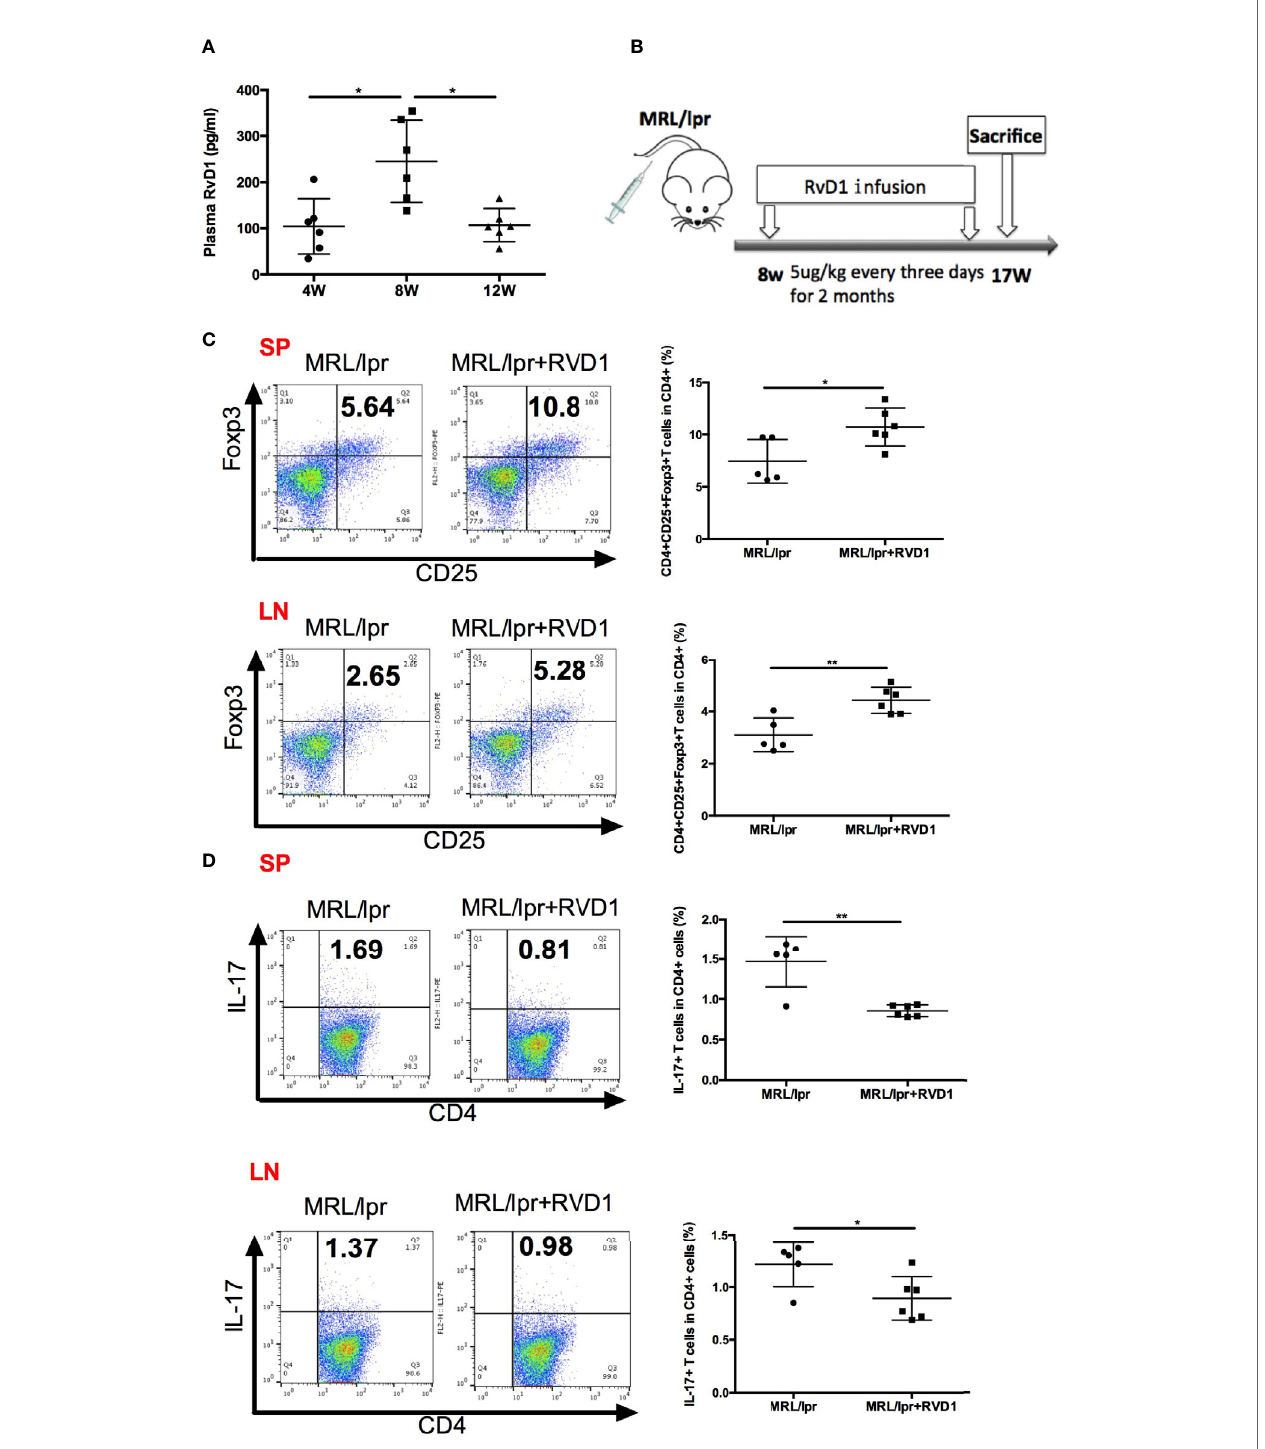
FIGURE 2 | RvD1 in fl uence the Treg/Th17 balance in MRL/ lpr mice. (A) Quanti fi cation with ELISA of RvD1 in the plasma of MRL/ lpr mice at 4, 8 and 12 weeks of age. (B) RvD1 treatment scheme (5 m g/kg) injections were performed every three days for 2 months, starting from 8 weeks of age. (C, D) Representative FACS analysis of Treg and Th17 of spleens and cervical lymph nodes. All data are mean ± SEM. n=5 in MRL/ lpr group; n=6 in MRL/ lp r+RvD1 treated group. * p < 0.05; ** p <